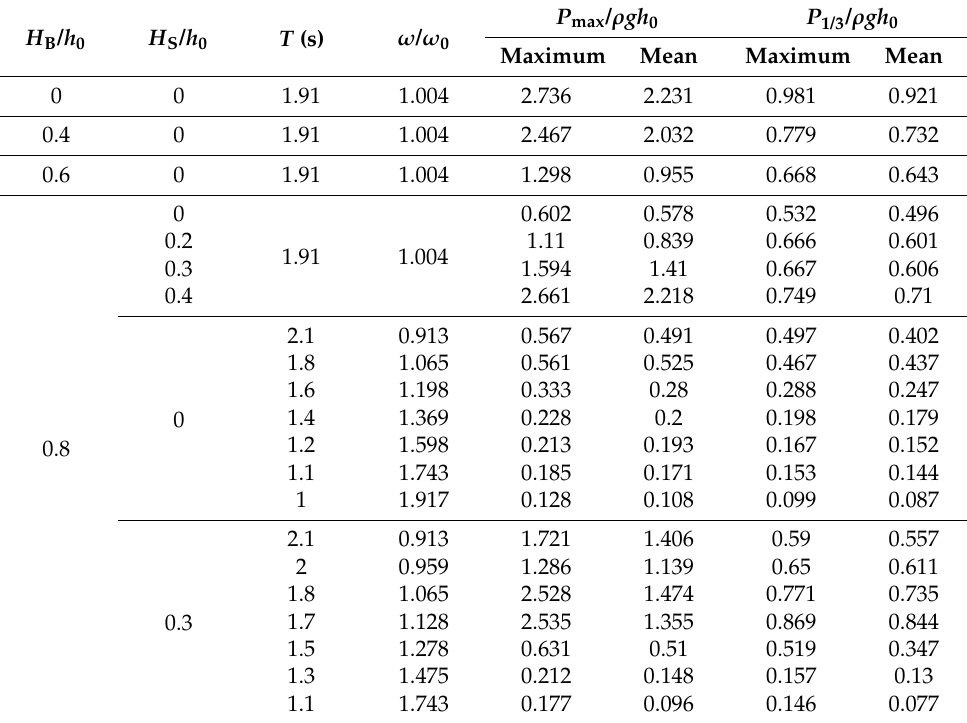
Table A1. Calculation conditions and pressure statistics of all